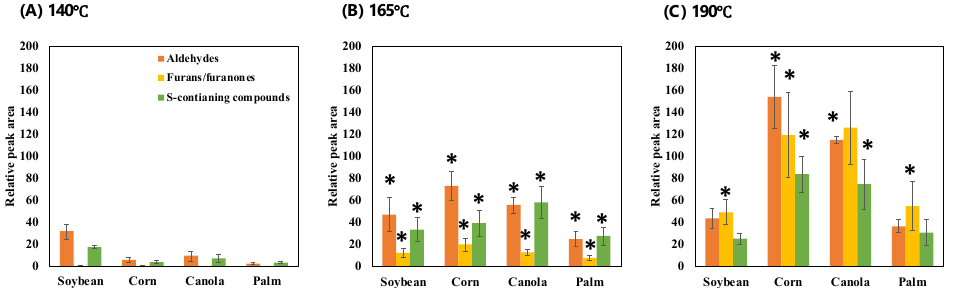
Figure 2. Changes of major chemical groups (aldehydes, furans/furanones, and sulfur-containing compounds) in WOF (Welsh onion fried) samples depending on different temperatures: (A) WOF prepared at 140°C, (B) at 165°C, (C) at 190°C. Asterisk indicates a statistically significant difference ( p -value <0.05) in the changes of chemical groups compared to the samples prepared at a lower temperature (140 or 165 °C ) .